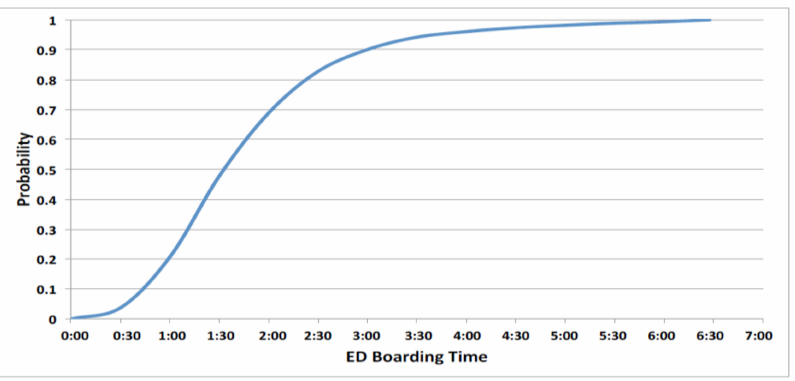
Figure 5. Cumulative distribution function of ED boarding